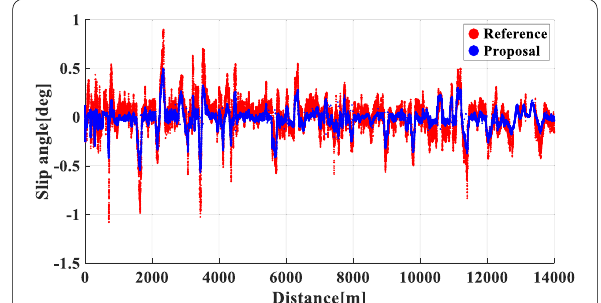
Fig. 15 Estimated slip angle (Urban highway)